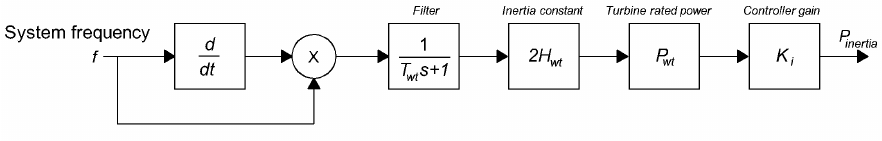
Figure 1. Block representation of Equation (2) in